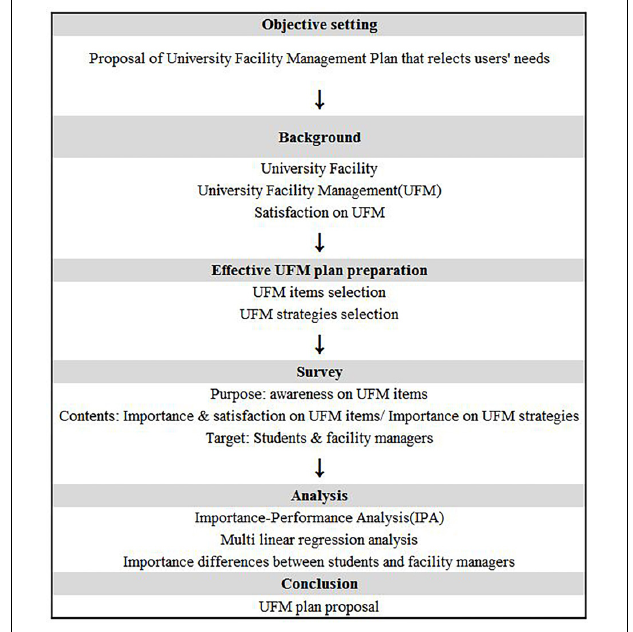
FIGURE 1 | Research